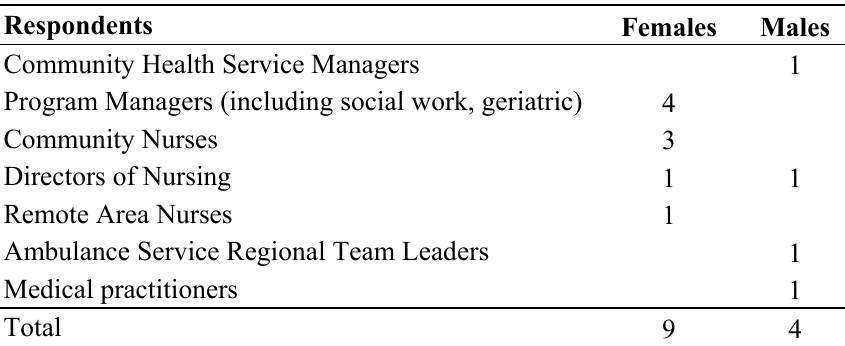
Table 1. Respondent categories.